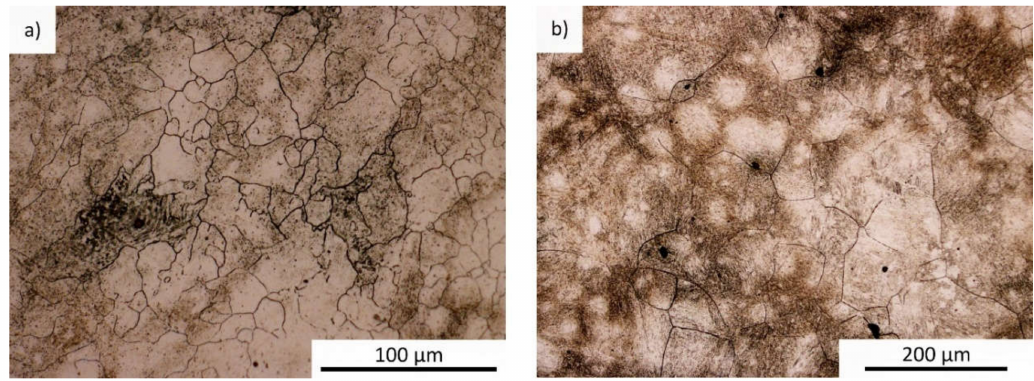
Figure 19. Prior austenitic grains after heating to di ff erent temperatures. ( a ) 840 ◦ C; ( b ) 1280 ◦ C.